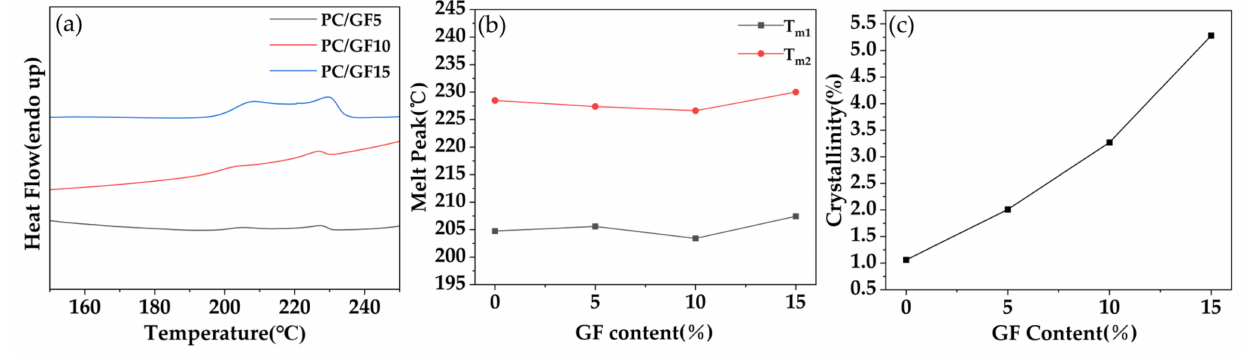
Figure 3. ( a ) DSC graph, ( b ) melting peak temperature graph and ( c ) variation of crystallinity